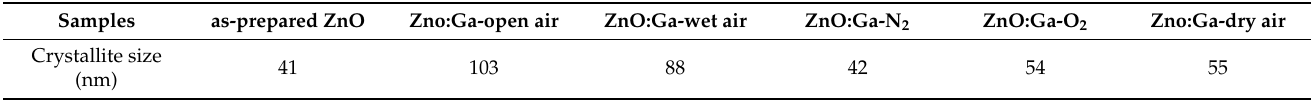
Table 2. The crystallite sizes of each sprayed NPs